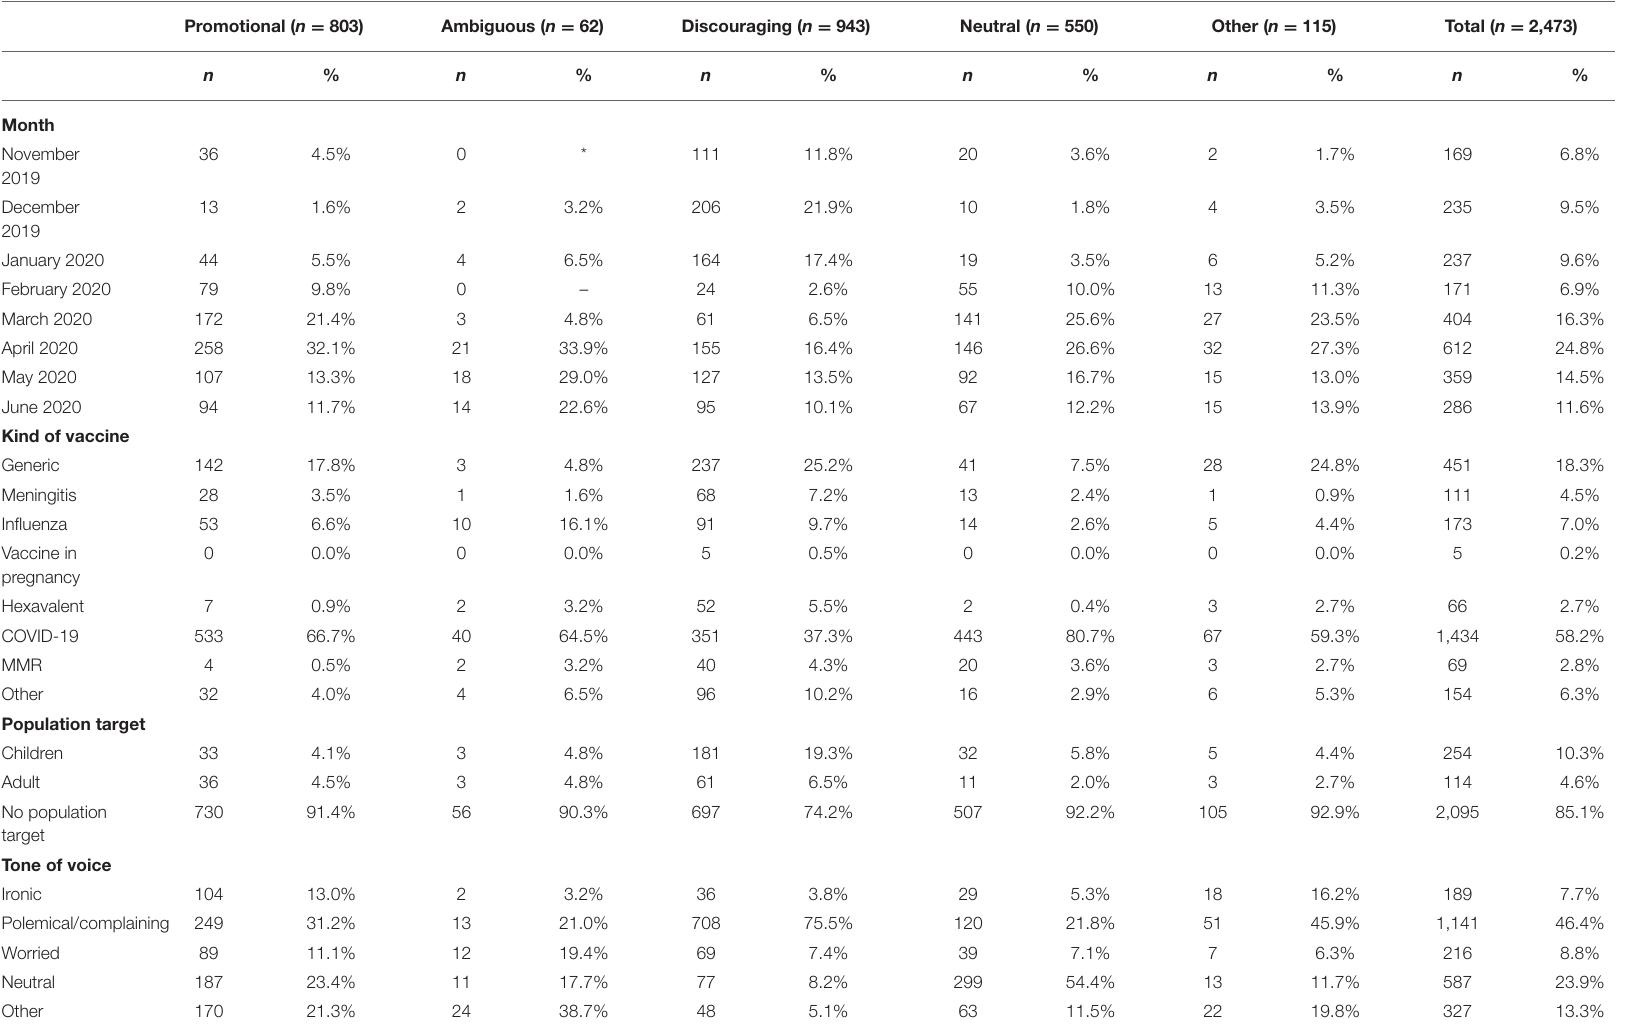
TABLE 3 | Characteristics of tweets by